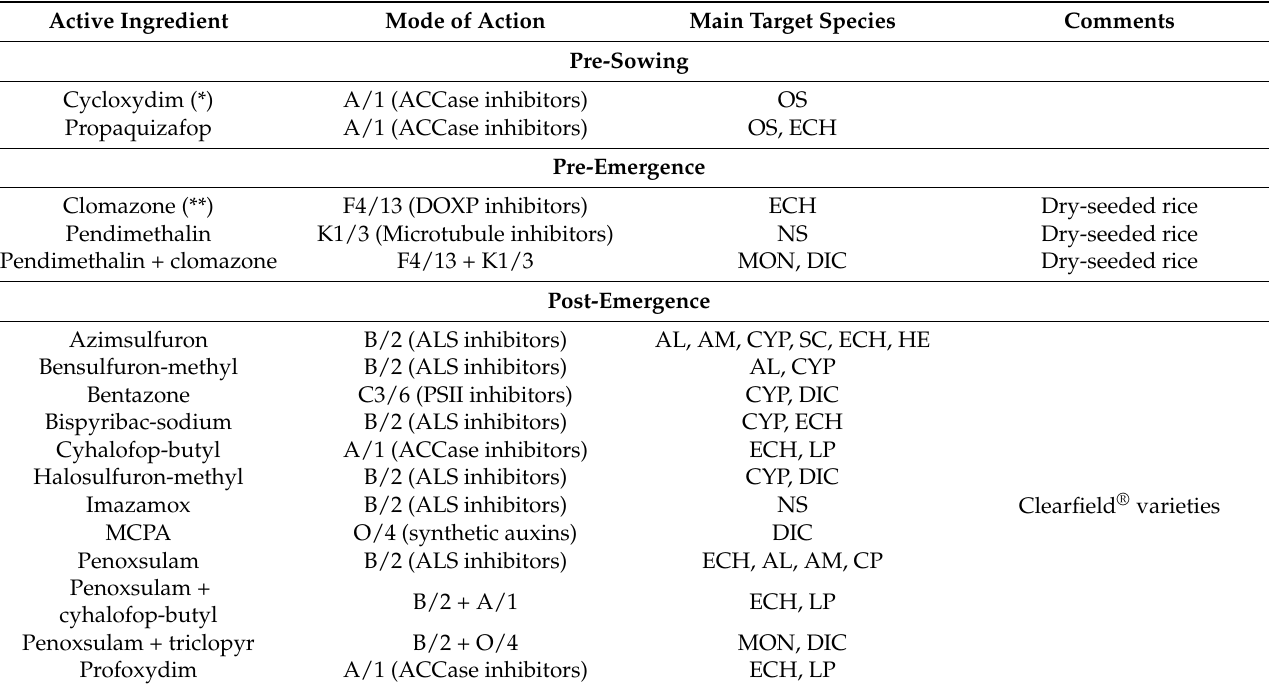
Table 5. Herbicides authorized for rice cultivation in Spain in the 2020 season